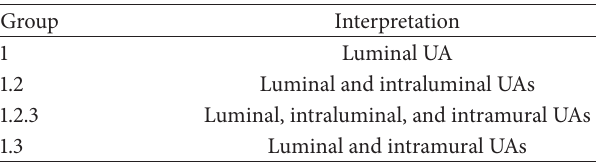
Table 1: Histopathological classification of unicystic ameloblas- tomas (UAs)